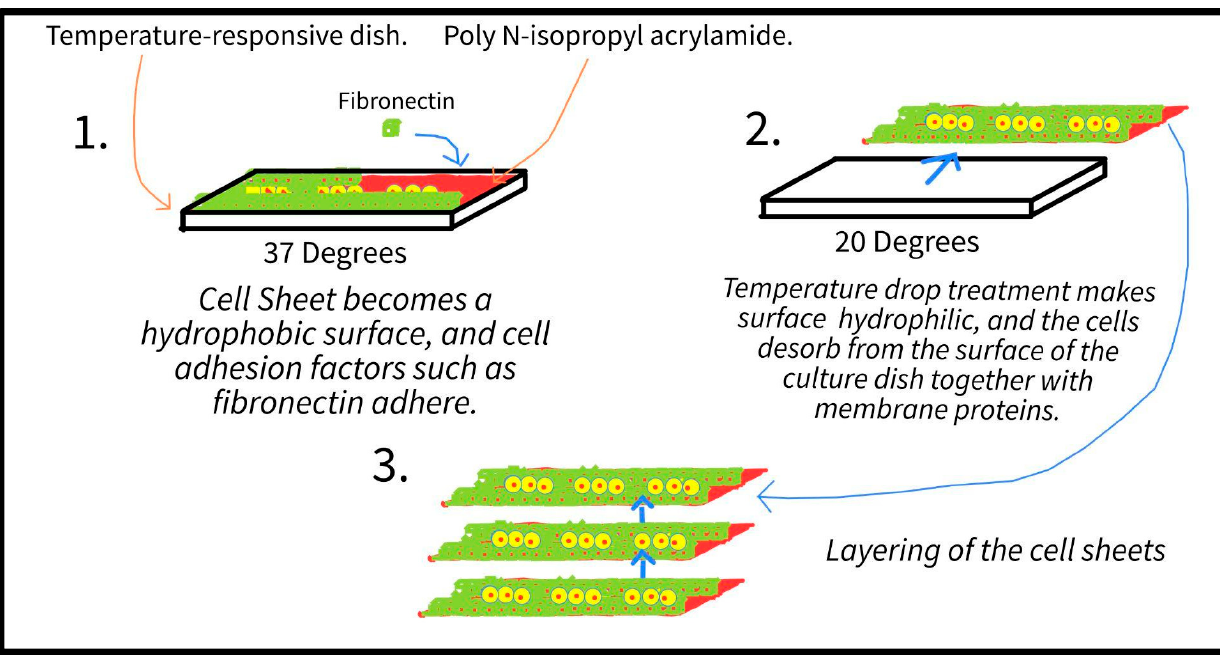
Figure 4. A more detailed explanation for the creation of cell sheets. Step 1 demonstrates the culture of the iPS-derived cardiomyocytes, step 2 describes the creation of each individual cell sheet, and step 3 describes the layering of the cell sheets the result in the final creation